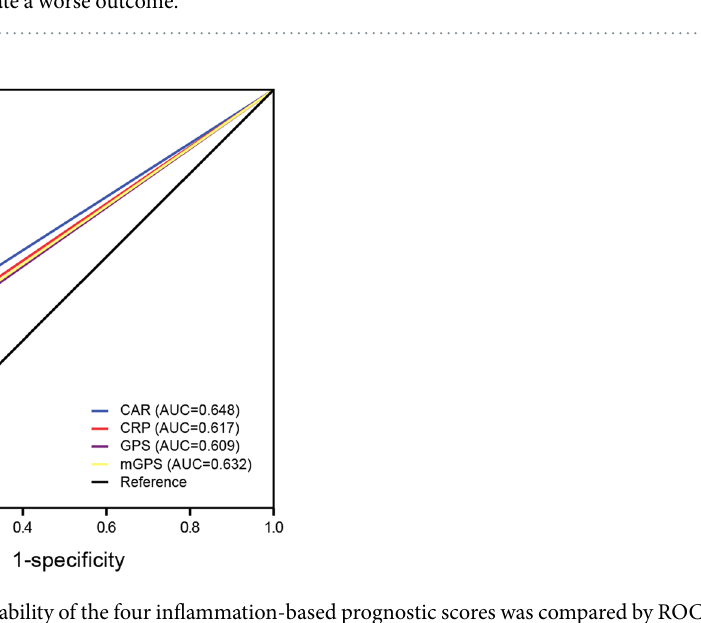
Figure 4. Hazard ratios (HRs) of CAR in different patient subgroups identified by ECOG PS, TNM stage and CA19-9. HRs > 1.0 indicate a worse outcome.